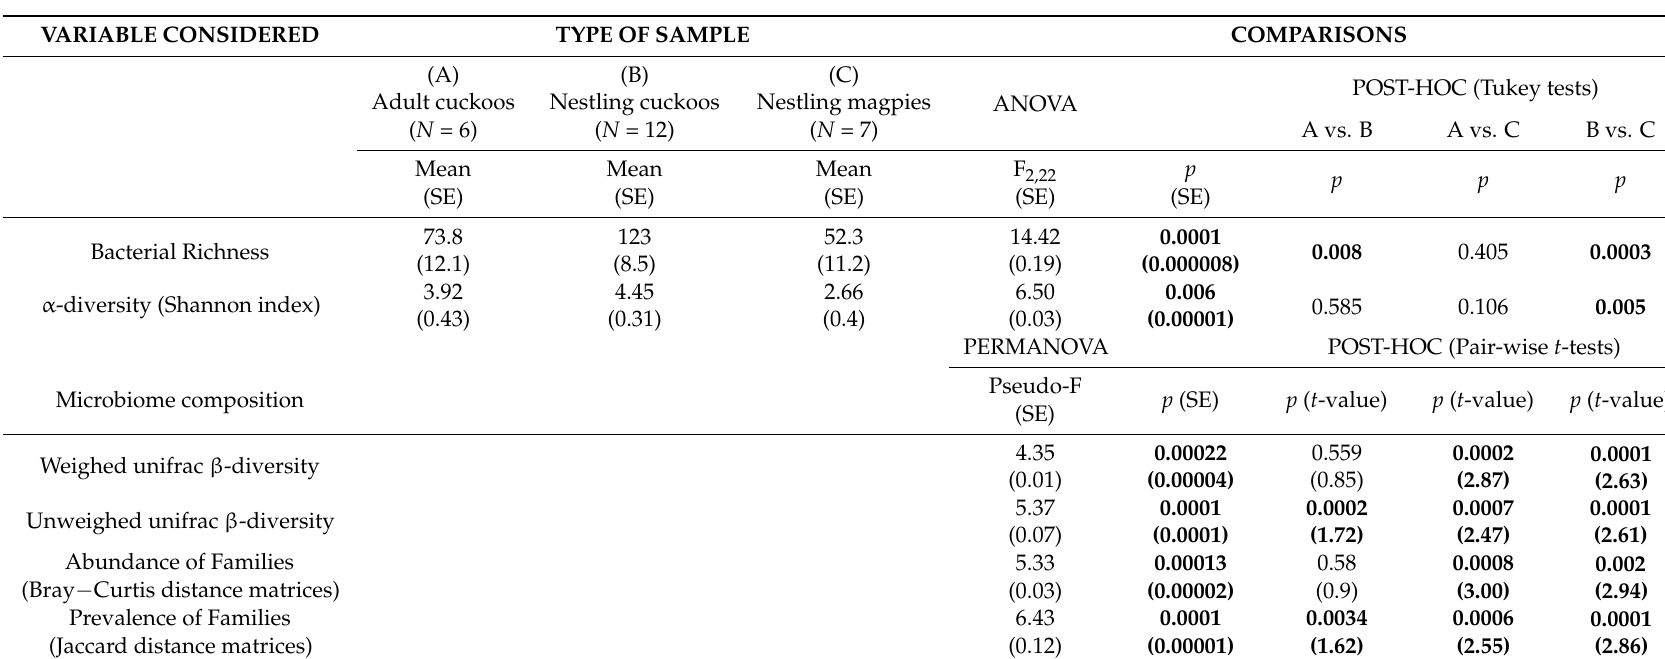
Table 1. Comparisons of gut microbiome of magpie and great spotted cuckoo nestlings and of great spotted cuckoo adults in terms of bacterial richness, α -diversity, composition (weighed and unweighed unifrac β -diversity) and abundance and prevalence of bacterial